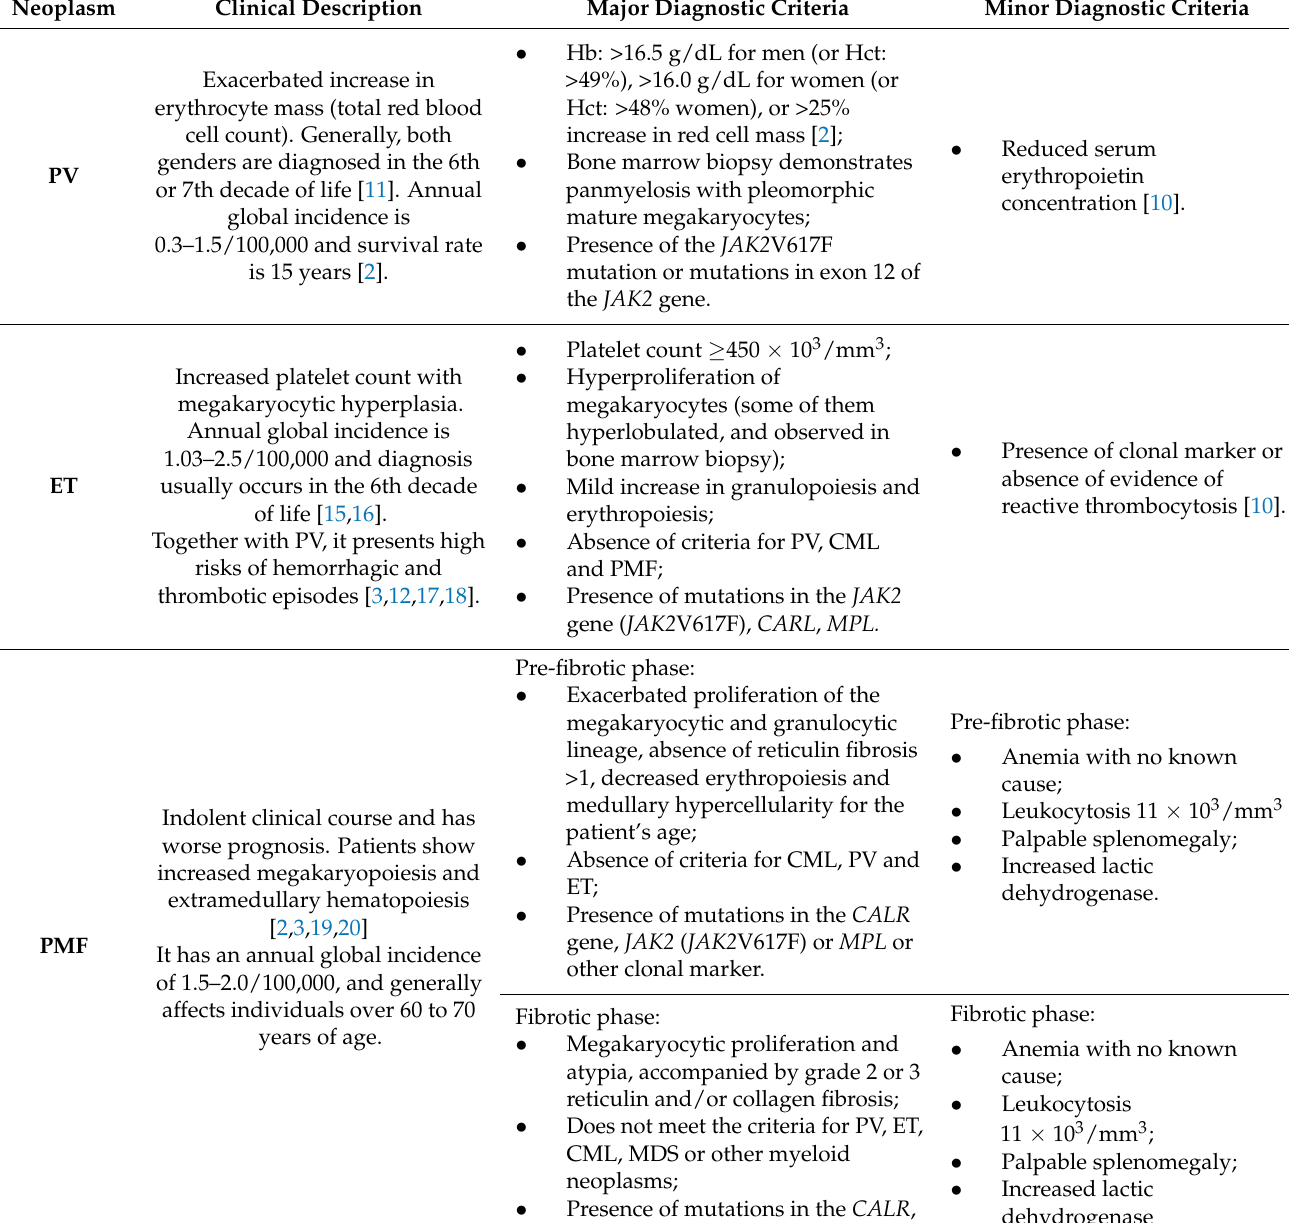
Table 1. Diagnosis criteria for classic BCR/ABL1 negative chronic myeloproliferative